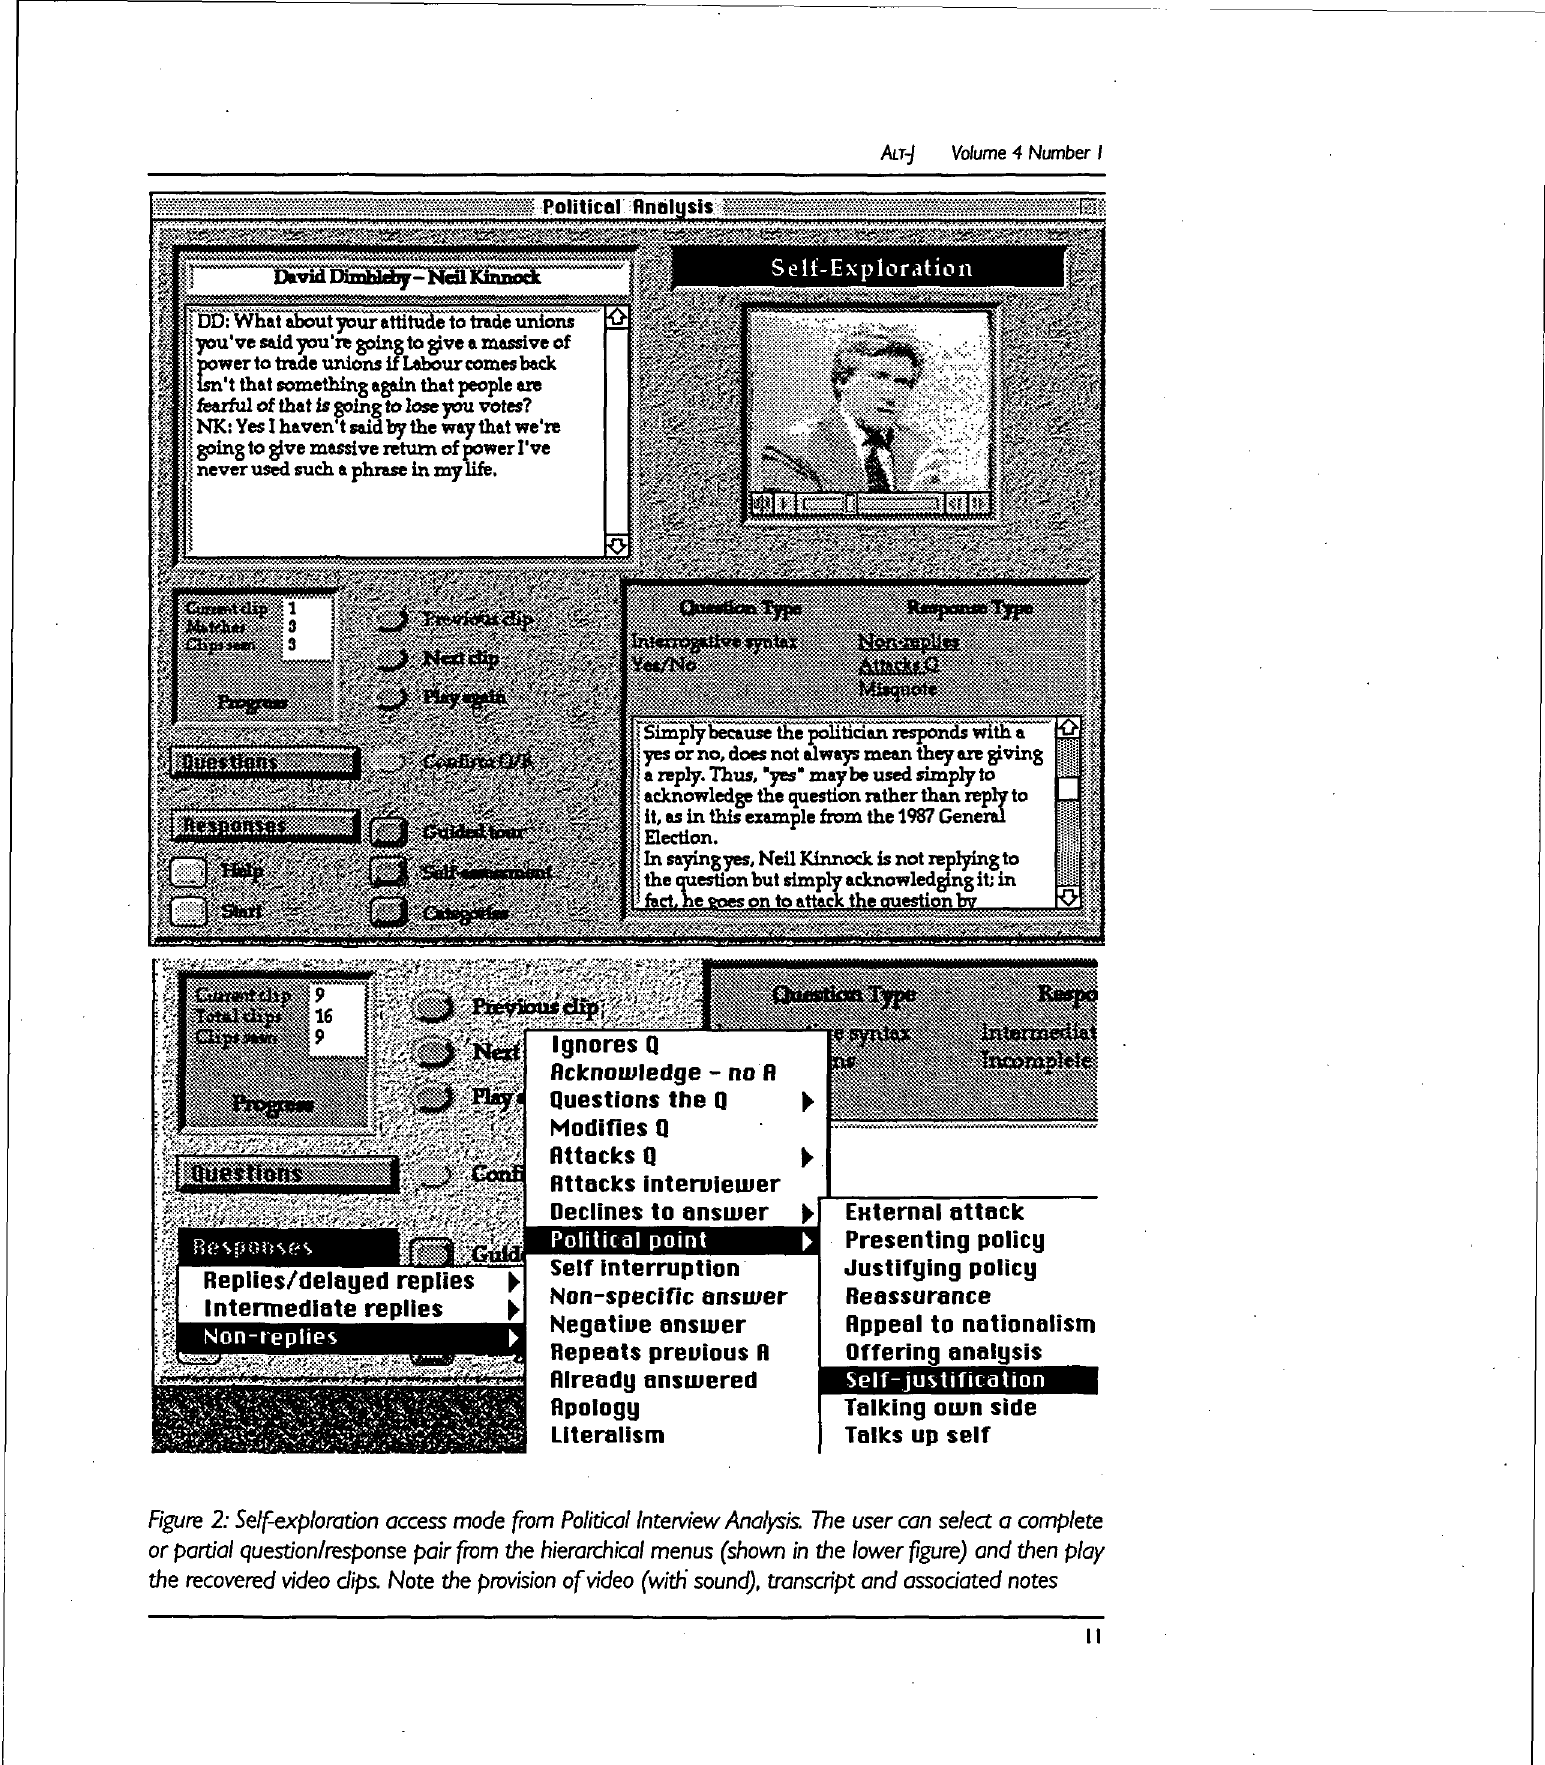
figure 2: Self-exploration access mode from Political Interview Analysis. The user can select a complete or partial question/response pair from the hierarchical menus (shown in the lower figure) and then play the recovered video clips. Note the provision of video (with' sound), transcript and associated